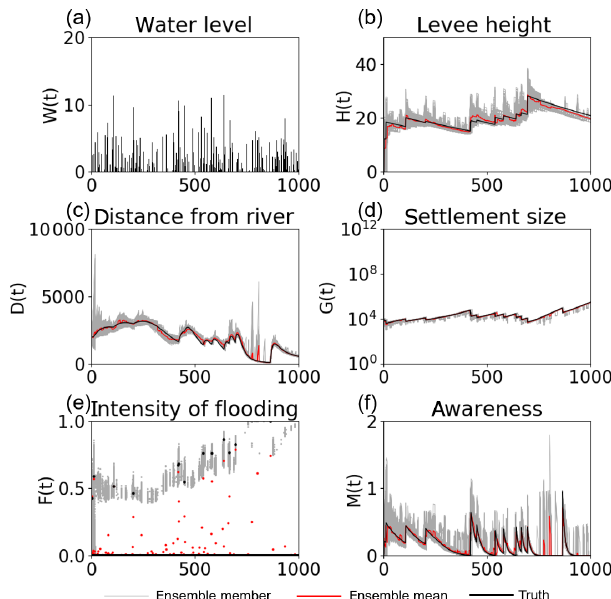
Figure 10. Time series of (a) the high water level W(t) , (b) the flood protection level (or levee height) H(t) , (c) the distance of the center of the mass of the human settlement from the river D(t) , (d) the size of the human settlement G(t) , (e) the intensity of flooding events F(t) , and (f) the social awareness of the flood risk M(t) simulated by the data assimilation experiment in which the observations of F , G , D , H , and M are assimilated into the model every 10 years, with 5000 ensembles, in experiment 3 (see Sect. 3.1.3). The time step is annual. Gray, red, and black lines are the ensemble members, their mean, and the synthetic truth,